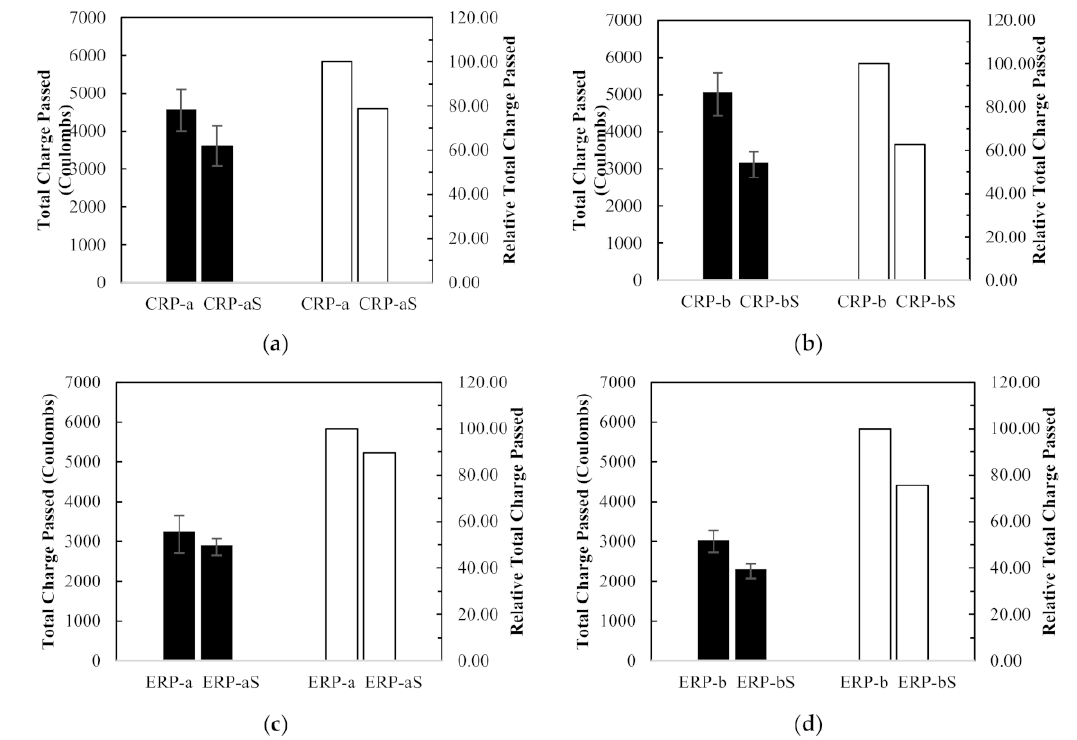
Figure 14. Rapid Chloride Penetration Test results and relative values between different mix design method with and without recycled concrete aggregate coating: ( a ) CRP-a, ( b ) CRP-b, ( c ) ERP-a, and ( d )